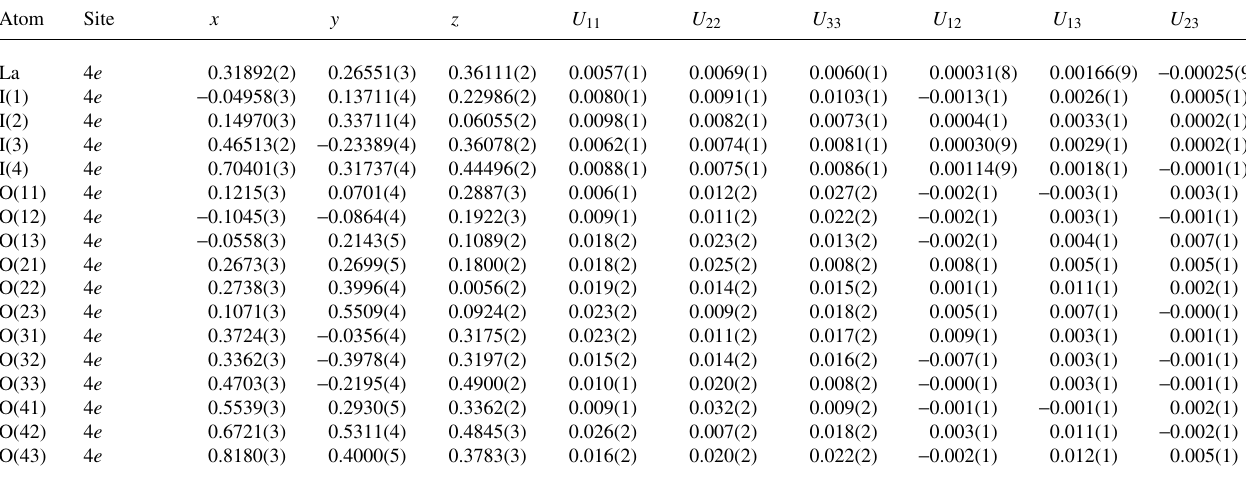
Table 2. Atomic coordinates and displacement parameters (in Å 2 ) .